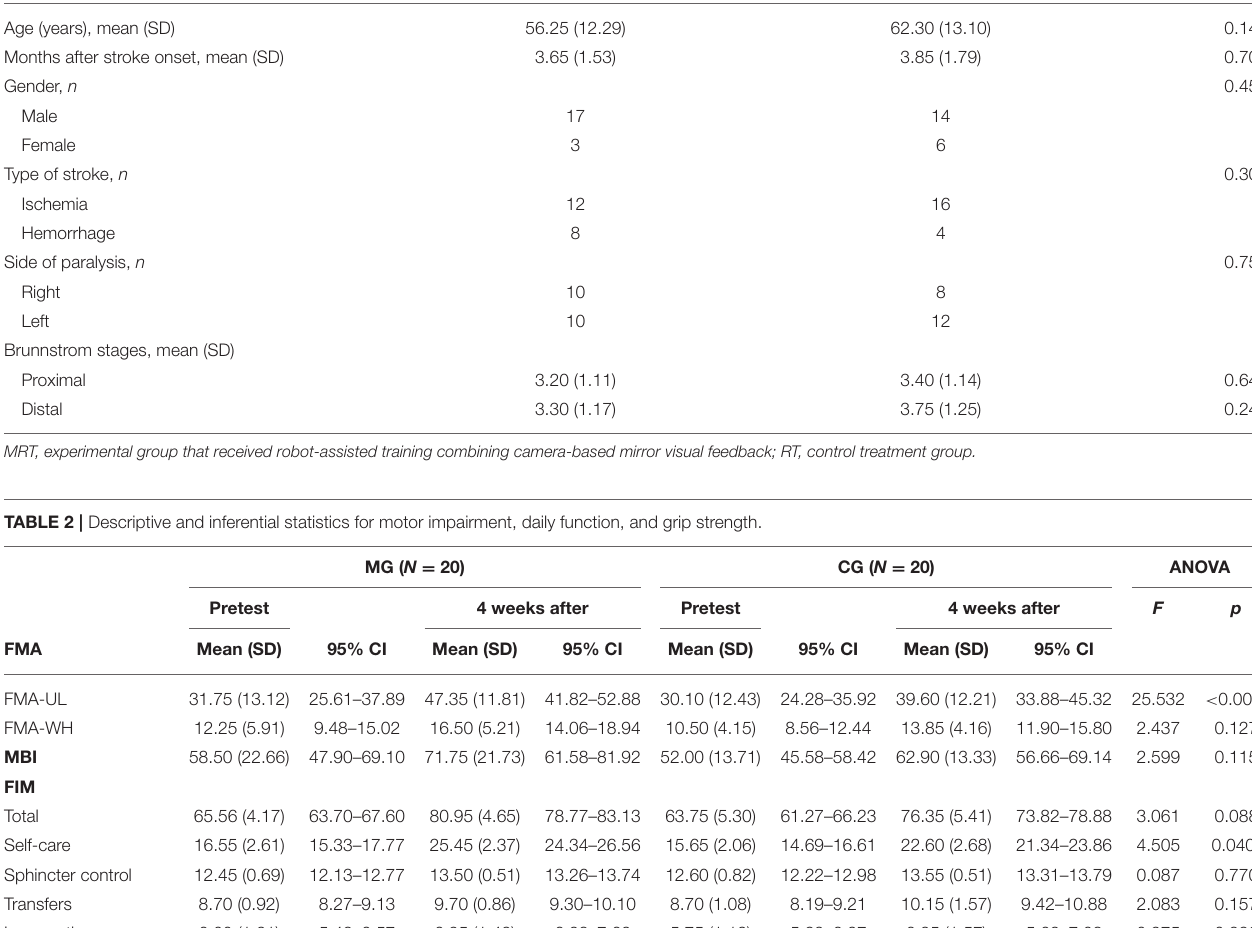
TABLE 1 | Demographic characteristics of patients. Characteristics